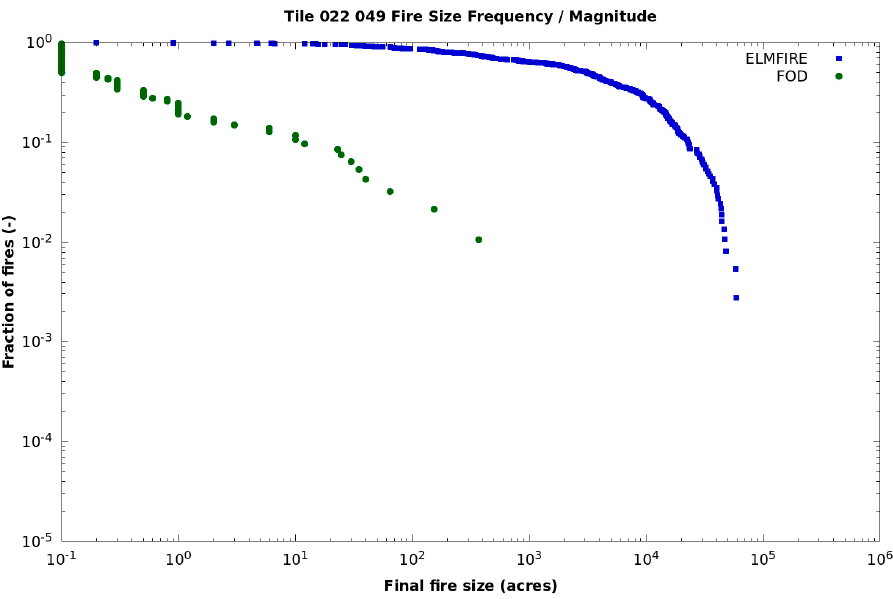
Figure 10. Historical and modeled fire sizes (in acres) versus intensity (flame length in ft).